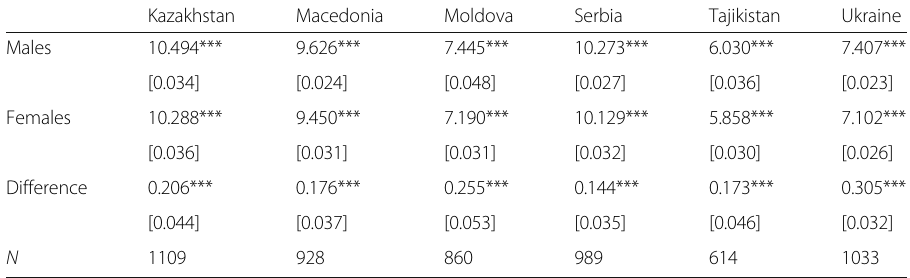
Table 4 Raw gender income gap in six Eastern European and Central Asian